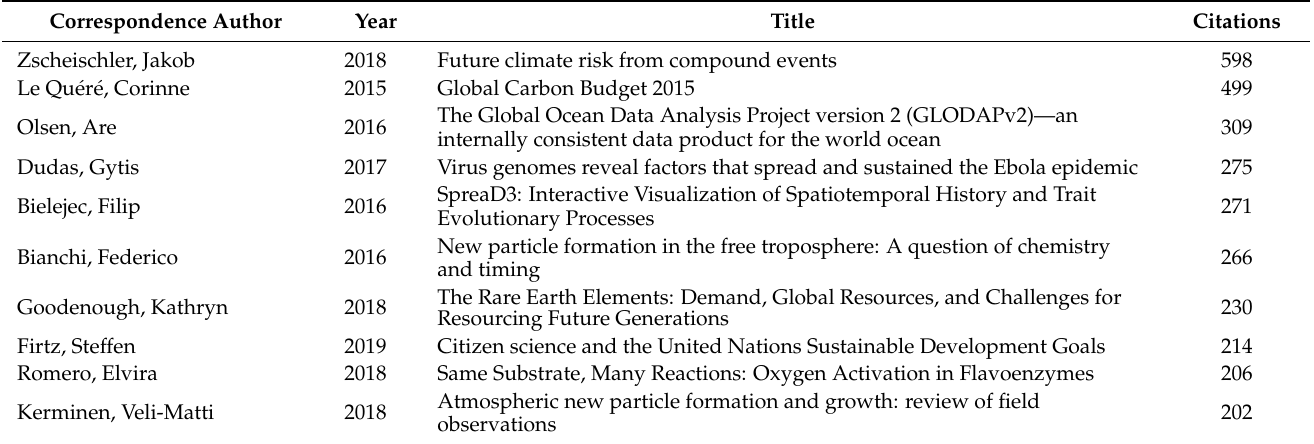
Table 3. Top 10 most-cited